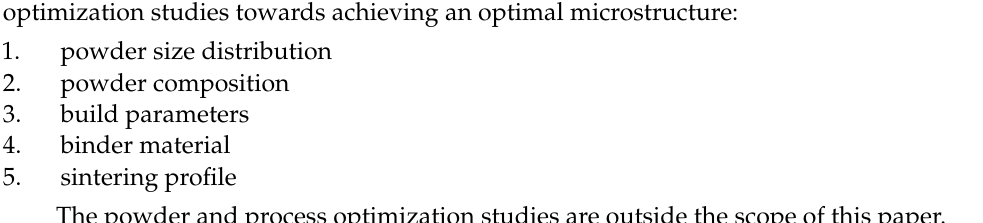
Figure 12. ThermoCalc prediction of equilibrium phases in SS316L as a function of temperature. BCC_A2 is the delta-ferrite phase. FCC_A1 is the austenite phase. A clear technical path to improve creep resistance includes powder and process op- timization studies towards achieving an optimal microstructure: 1.